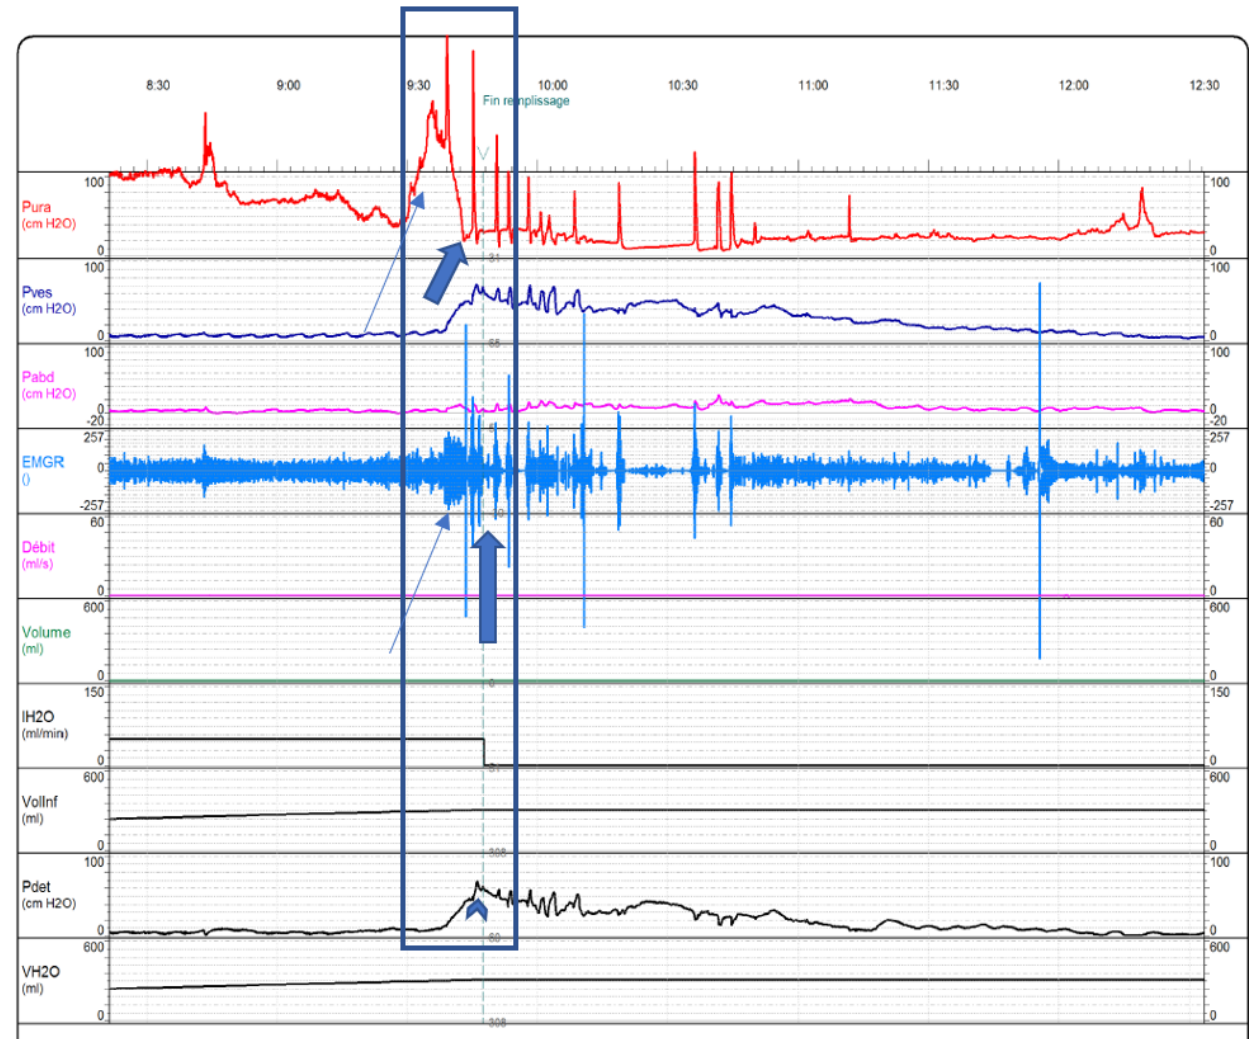
Figure 1. Urodynamics of type 1 DSD according to ICS classification, with an increase in EUS activity (line arrows) following a sudden decrease (block arrows) in both EMG and EUS-pressure channels as the detrusor pressure peaks and starts to slowly decrease (arrowhead), source: UdEPP Rehazenter database.